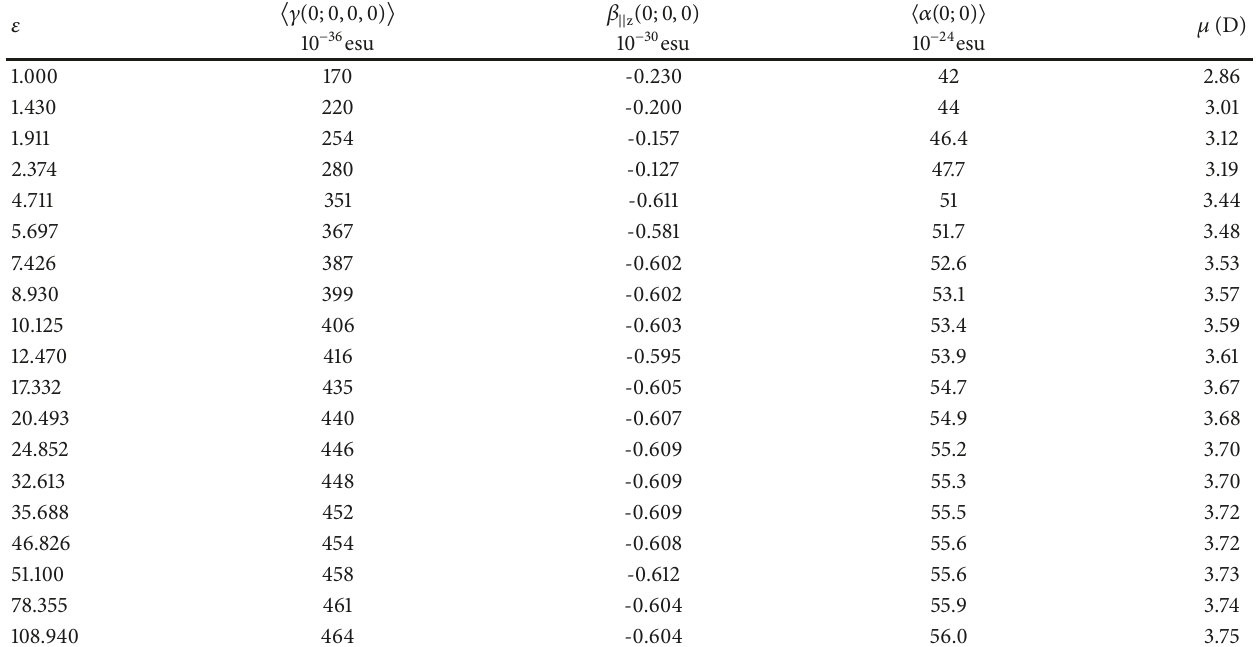
Table 4: DFT static results for the EPAF electrical parameters.